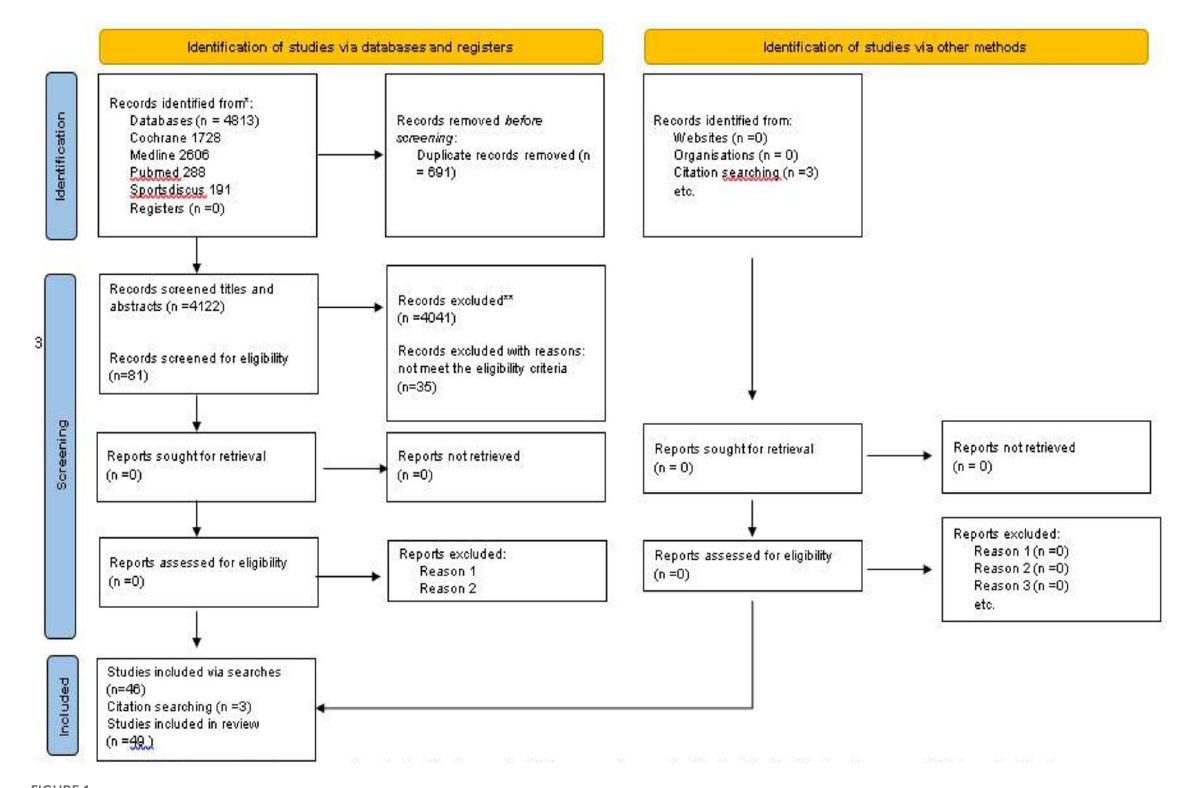
FIGURE1 PRISMA 2020 flow